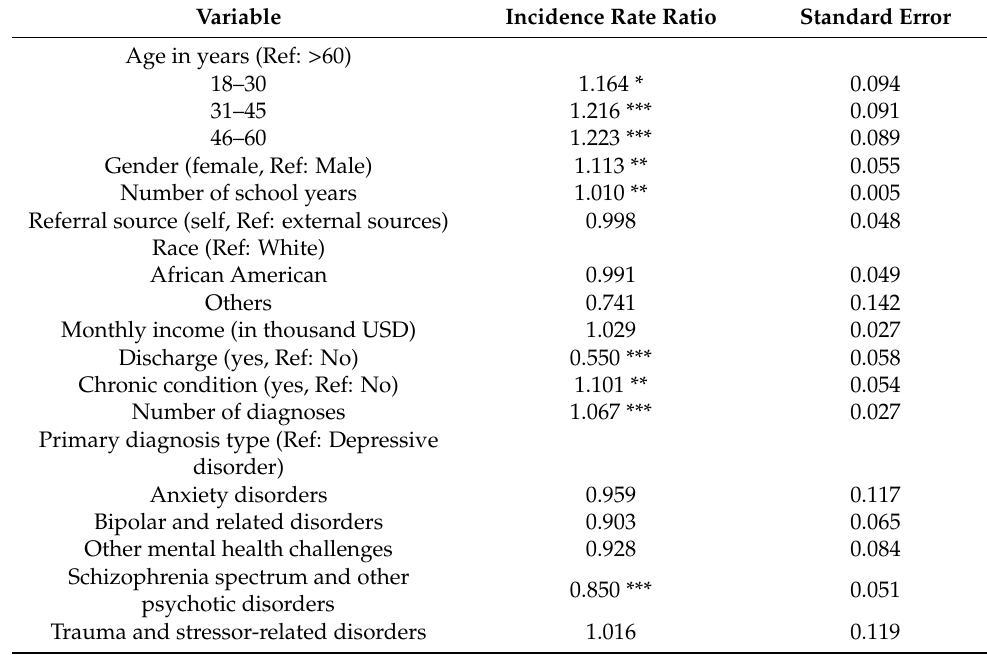
Table 3. Incidence Rate Ratio from Negative Binomial regression